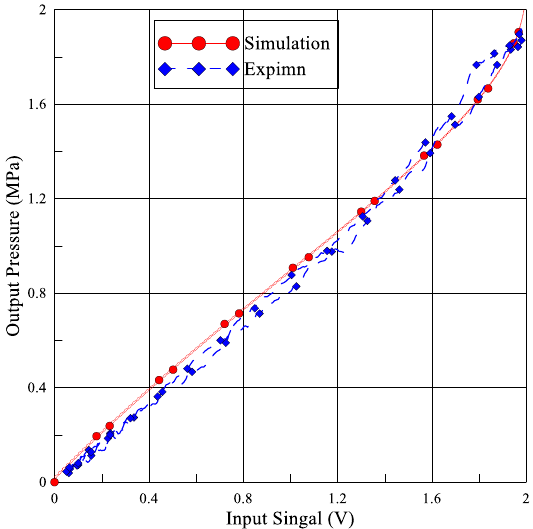
Figure 8. Simulation and test static characteristic results.